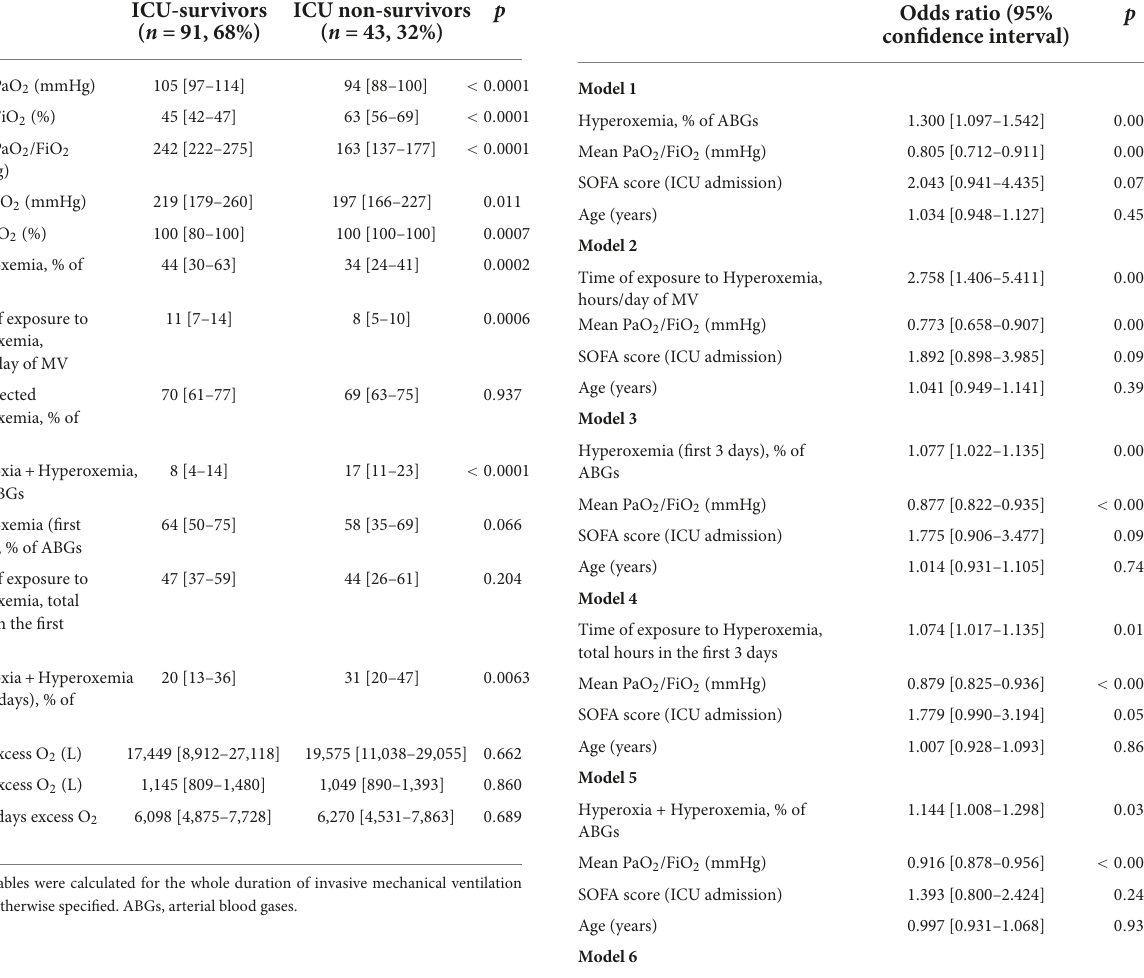
TABLE 4 Binomial logistic regression models for the association between hyperoxemia and